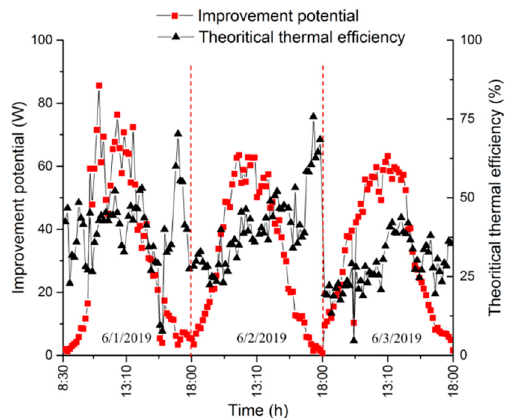
Figure 16. The variation of improvement potential and theoretical thermal efficiency.